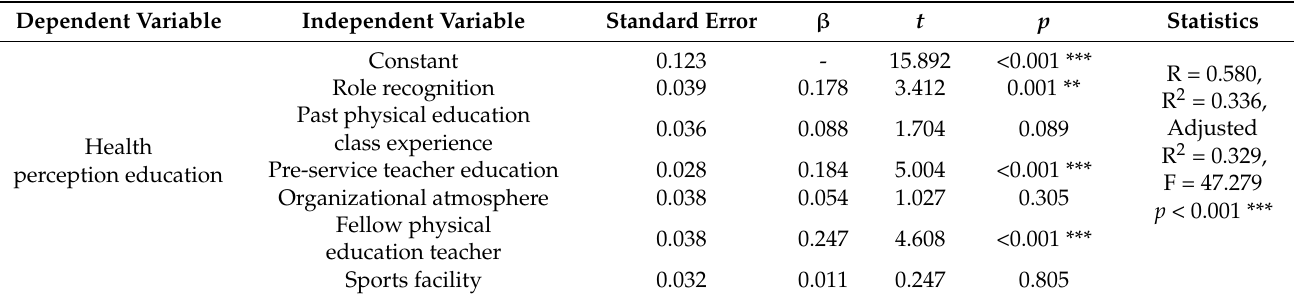
Table 7. The effect of occupational socialization of beginning physical education teachers on health perception